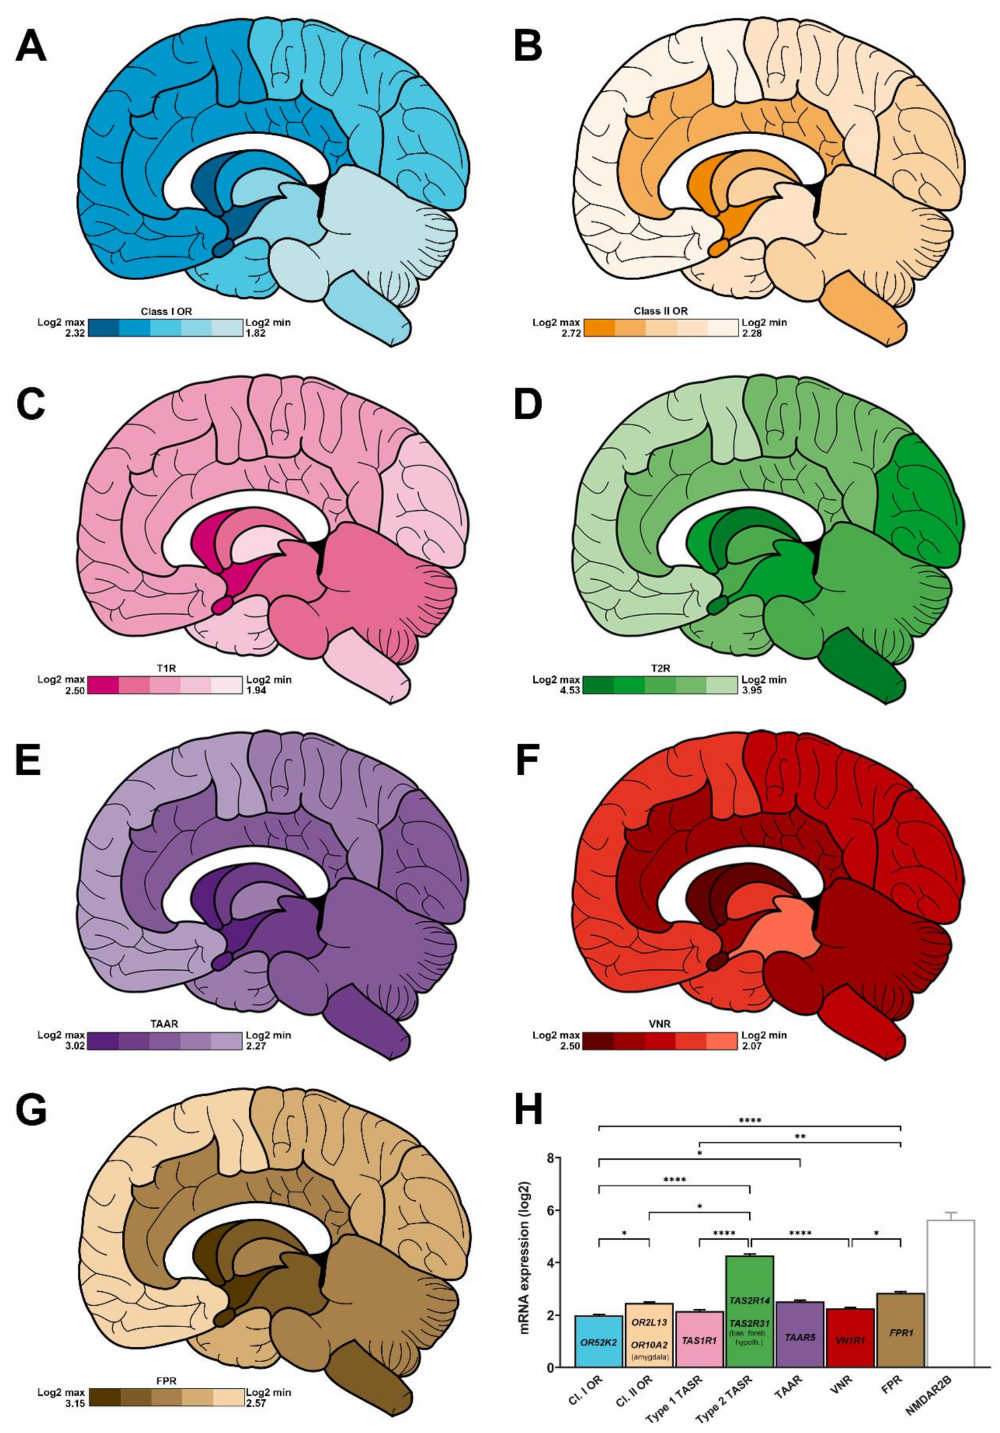
Figure 3. Regionalised mean expression of chemoreceptors in a human brain collected from a 31-year-old Caucasian subject. ( A – G ), log2 expression for class I ( A , blue) and class II ( B , orange) olfactory receptors, type 1 ( C , pink), and type 2 ( D , green) taste receptors, trace amine-associated receptors ( E , purple), vomeronasal receptors ( F , red), and formyl peptide receptors ( G , brown). The maximum and minimum expression levels are indicated in the bottom left panel for each family representation. ( H ) Histogram showing the average expression for each family in the whole brain (n = 13 main areas). The most expressed members for each family is indicated inside each bar. NMDAR2B gene expression (empty bar, grey, was added as a positive control). *: p < 0.05, **: p < 0.01, ****: p < 0.0001 (Kruskal–Wallis test followed by Dunn’s multiple comparisons post hoc test). For clarity purposes, NMDAR2B was excluded from the statistical